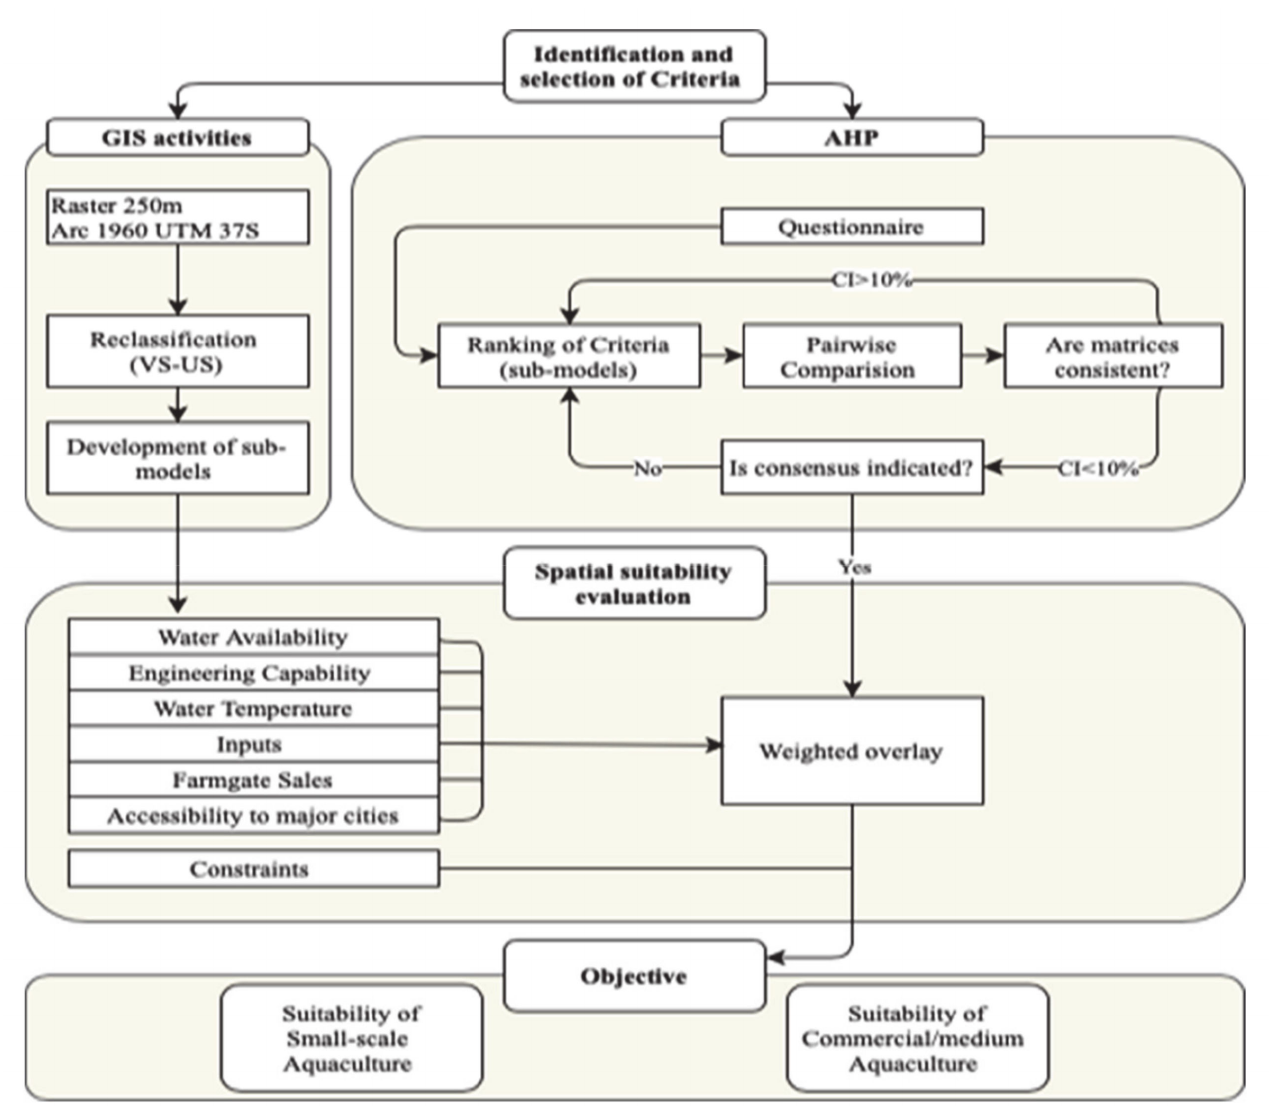
Figure 2. Schematic overview of the procedures integrating GIS and MCE to assess the suitability of small-scale and commercial fish pond farming in